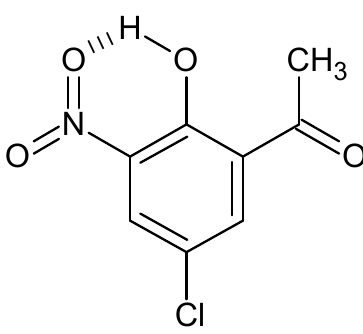
Figure 9. The structure of 5-chloro-3-nitro-2-hydroxyacetophenone ( VI ).